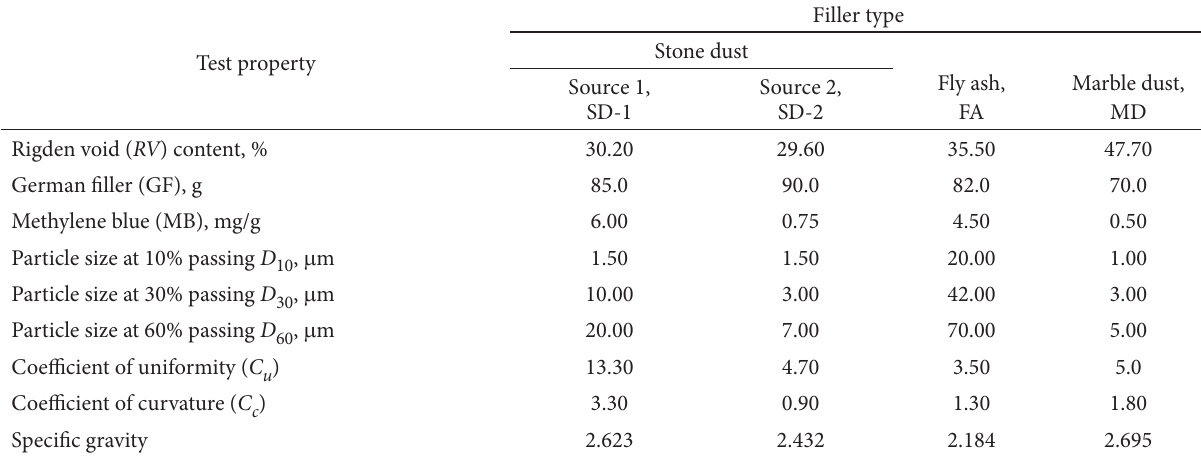
Fig. 2. FESEM photomicrographs: a – stone dust (SD-1); b – stone dust (SD-2); c – fly ash (FA); d – marble dust (MD) Table 3. Filler characterization